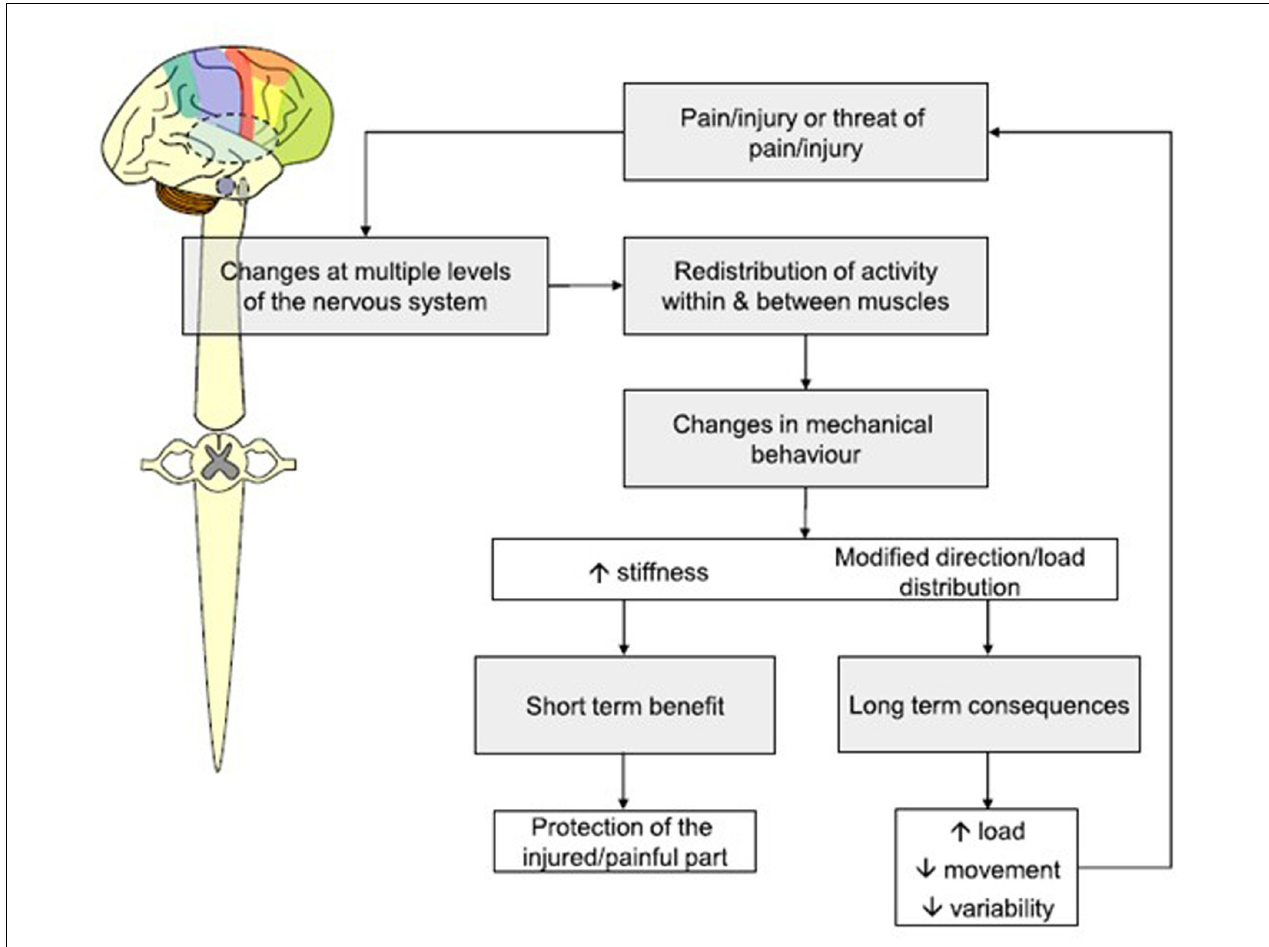
FIGURE 1 | Mechanisms through which pain leads to re-distribution of activity within, and between, muscles. Used by permission from Hodges and Tucker